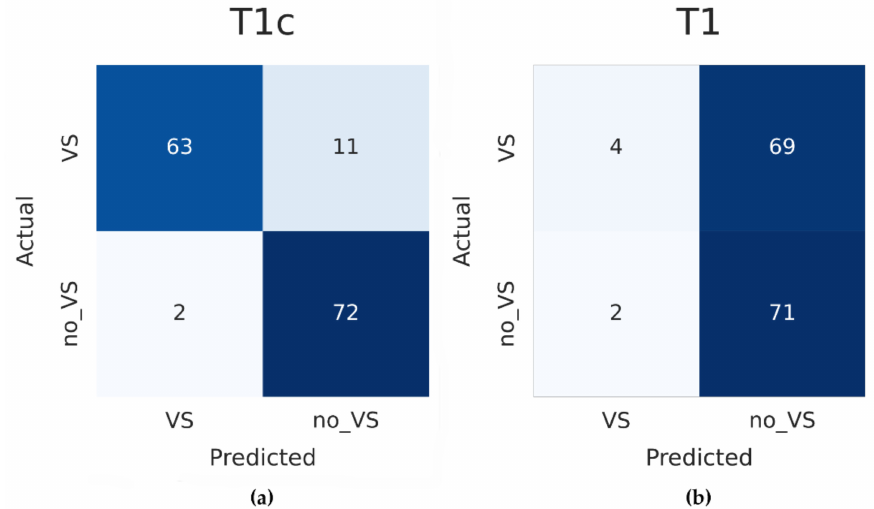
Figure 4. ( a ) Confusion matrix of the external validation with T1c MRI slices; ( b ) confusion matrix of the external validation with T1 MRI slices. VS: vestibular schwannoma.